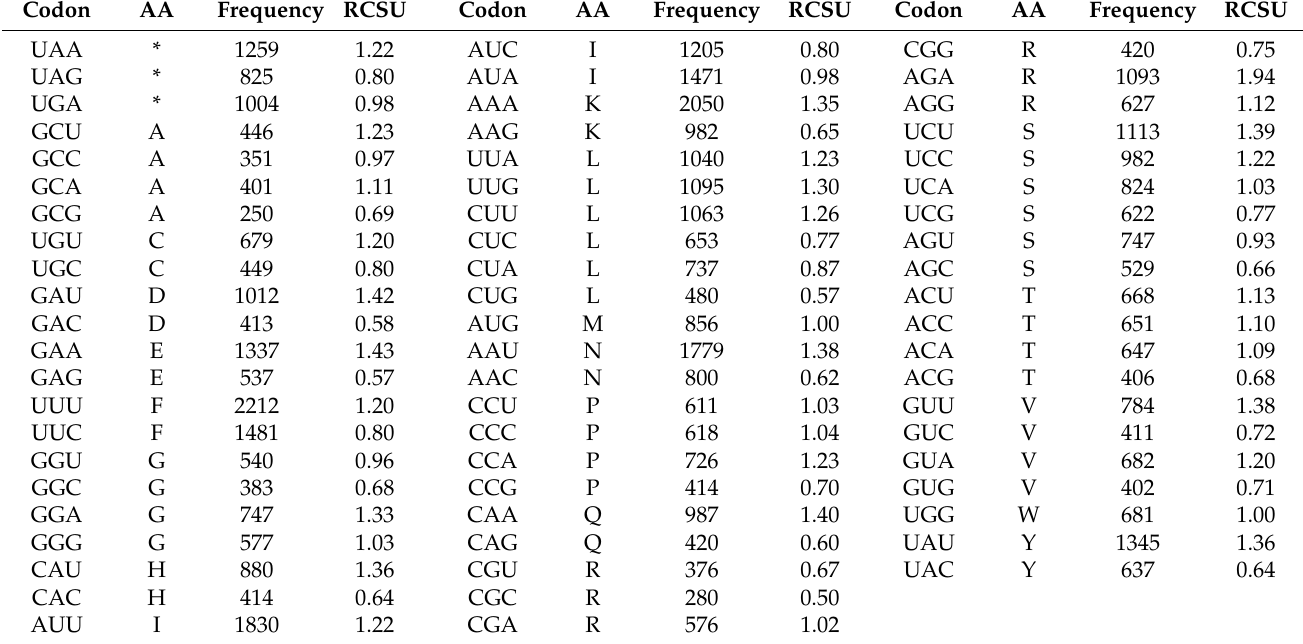
Table 3. Relative synonymous codon usage (RSCU) for protein-coding genes in O. baviensis